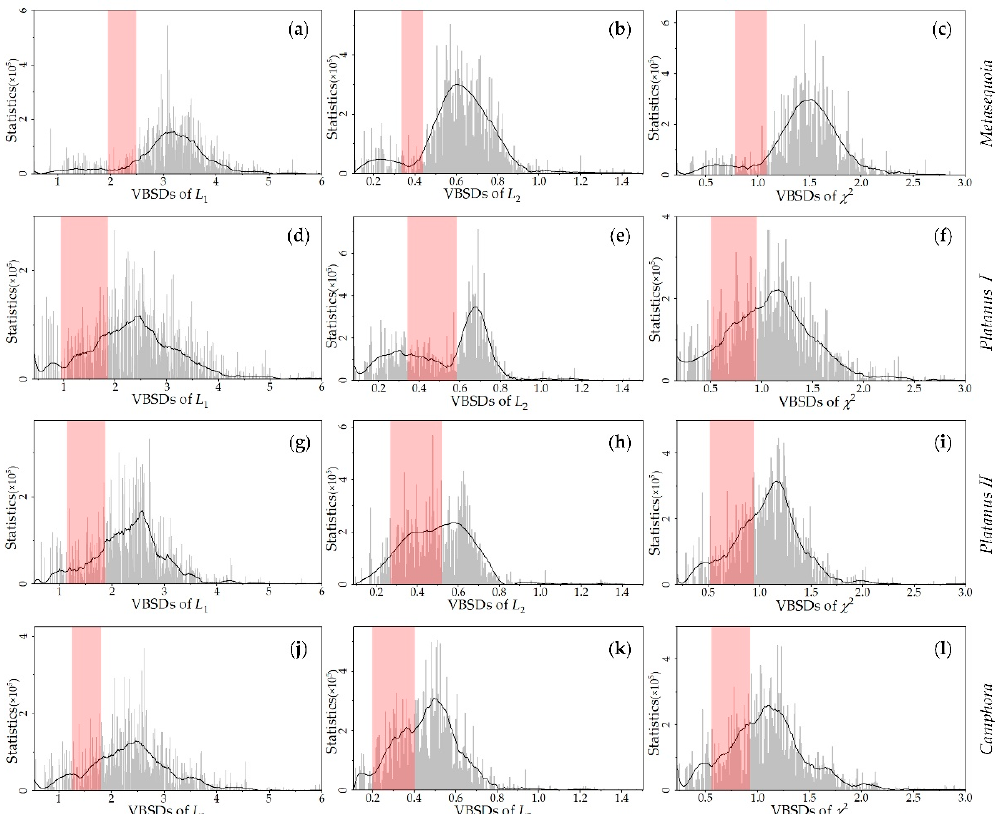
Figure 6. The distributions of VBSDs images for three distances and four tree species: Metasequoia ( a – c ); Platanus I ( d – f ); Platanus II ( h – i ); Camphora ( j – l ). The smoothed histograms are shown by solid lines. The ranges of the threshold are labeled in red. Table 2. The VBSD thresholds for four tree species in the proposed method. Tree